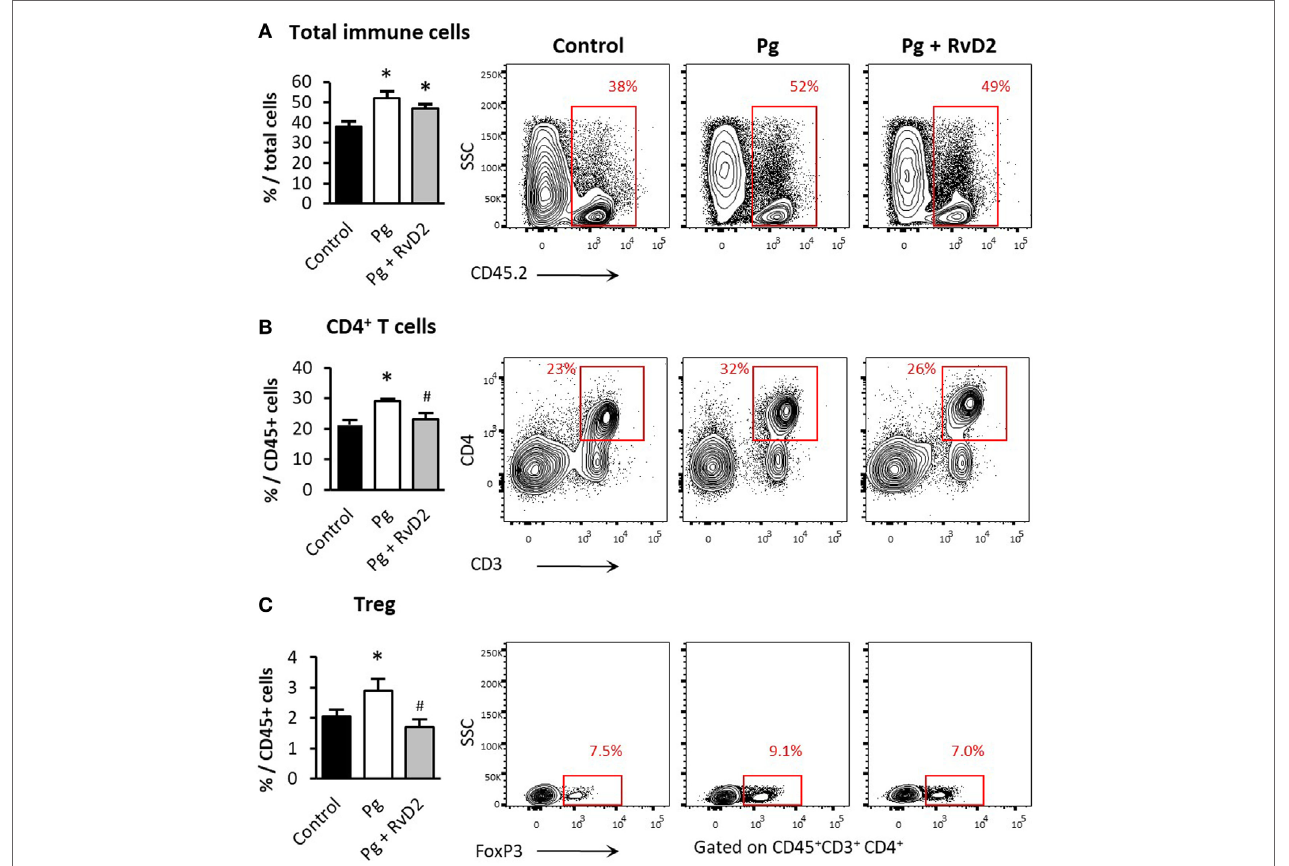
FigUre 3 | Resolvin D2 treatment prevents CD4 + and Treg accumulation in the gingiva. Quantification by flow cytometry analysis of (a) total immune cells, (B) CD4 + T-cells, and (c) Treg cells, in line with their representative FACS plots 6 weeks after the last infection (Treg FACS plots are gated on CD45 + CD3 + CD4 + cells). Data represent the mean of six mice per group ± SEM of two independent experiments, * p < 0.05 relative to control group. # p < 0.05 relative to Pg